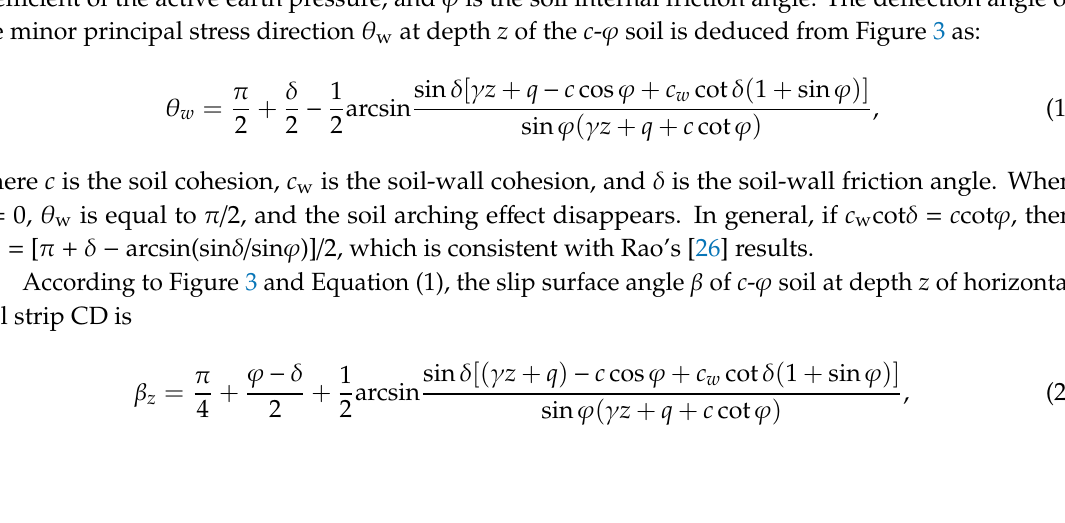
Figure 3. Mohr stress circle analysis.